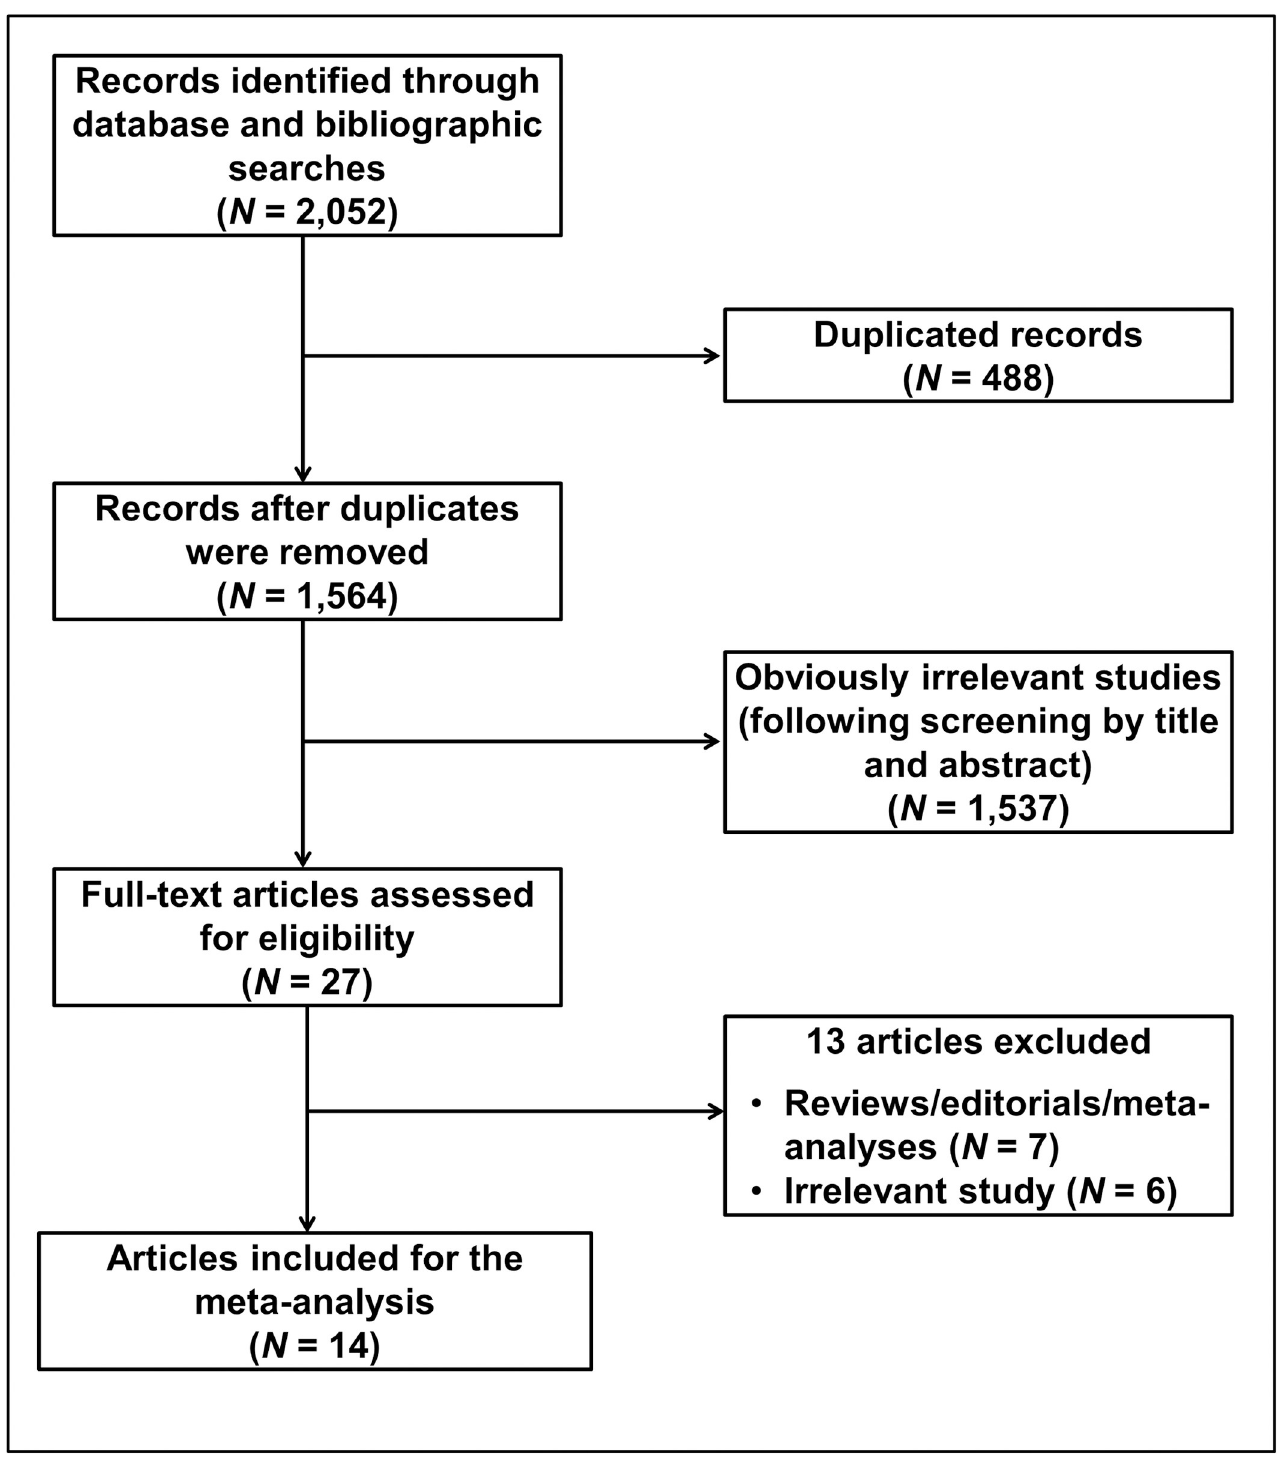
Fig 1. Flow diagram of study selection.